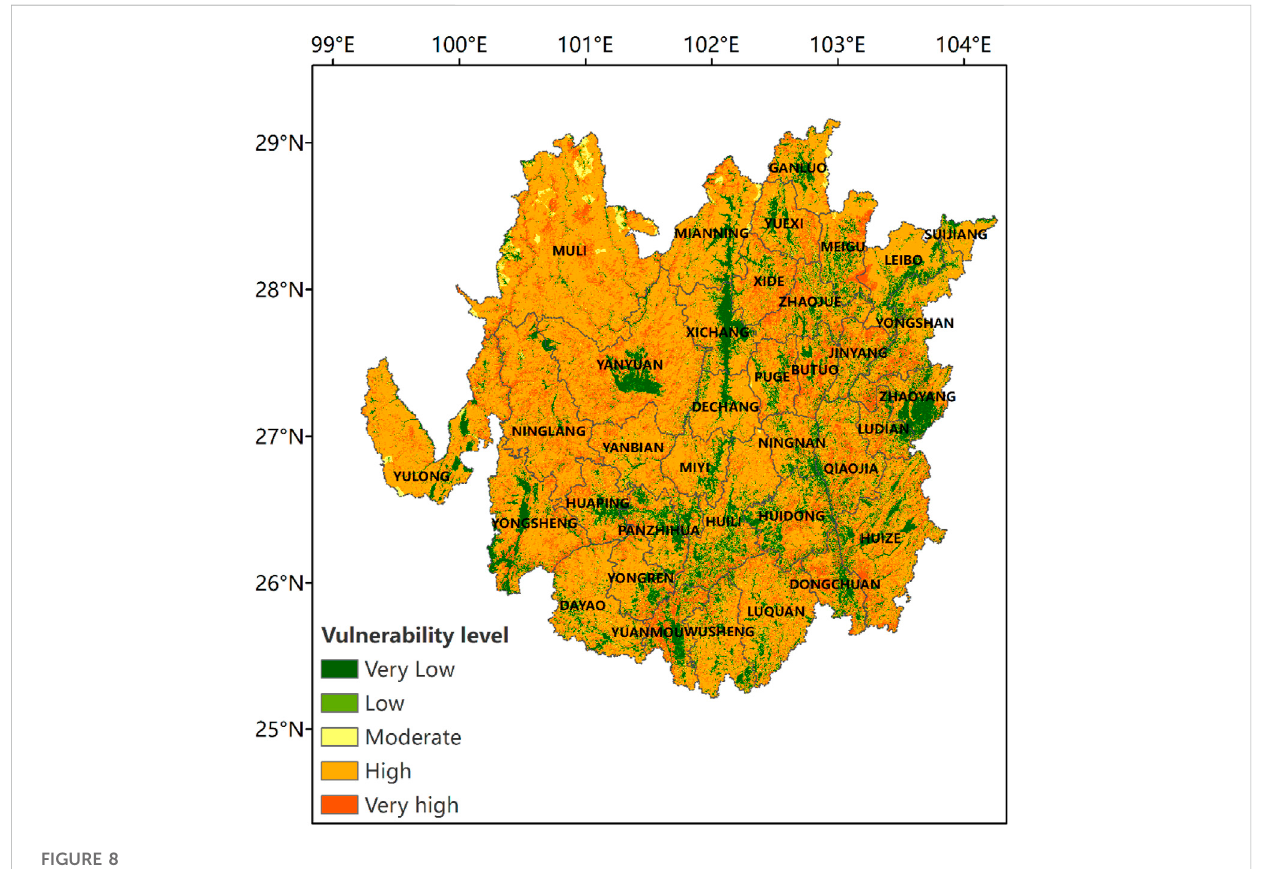
FIGURE 8 Spatial pattern of